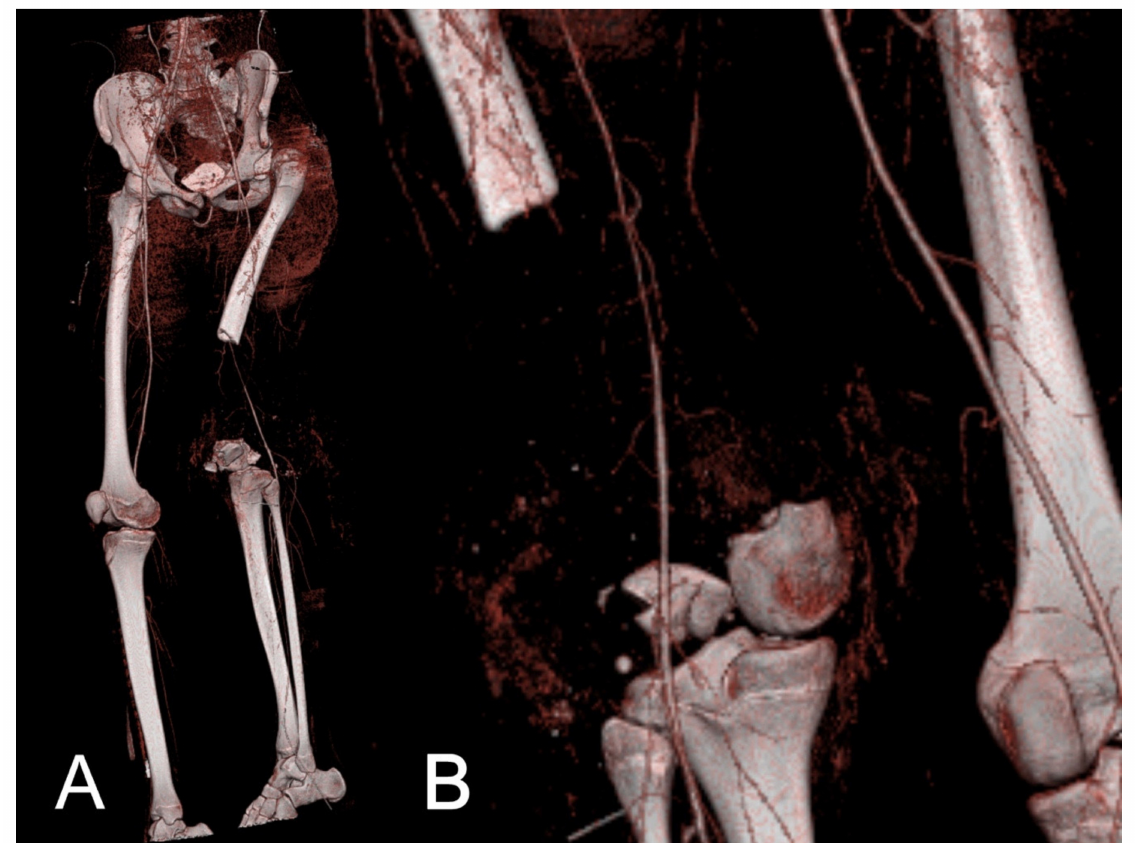
Figure 1. Massive bone defect in a 15-year-old patient on the left distal femur. Angiography was performed to decide between reconstruction and amputation and to plan the surgery. Oblique–anterior view. ( A ) The femoral artery has a reduced caliber but remains intact with a continuous flow. ( B ).